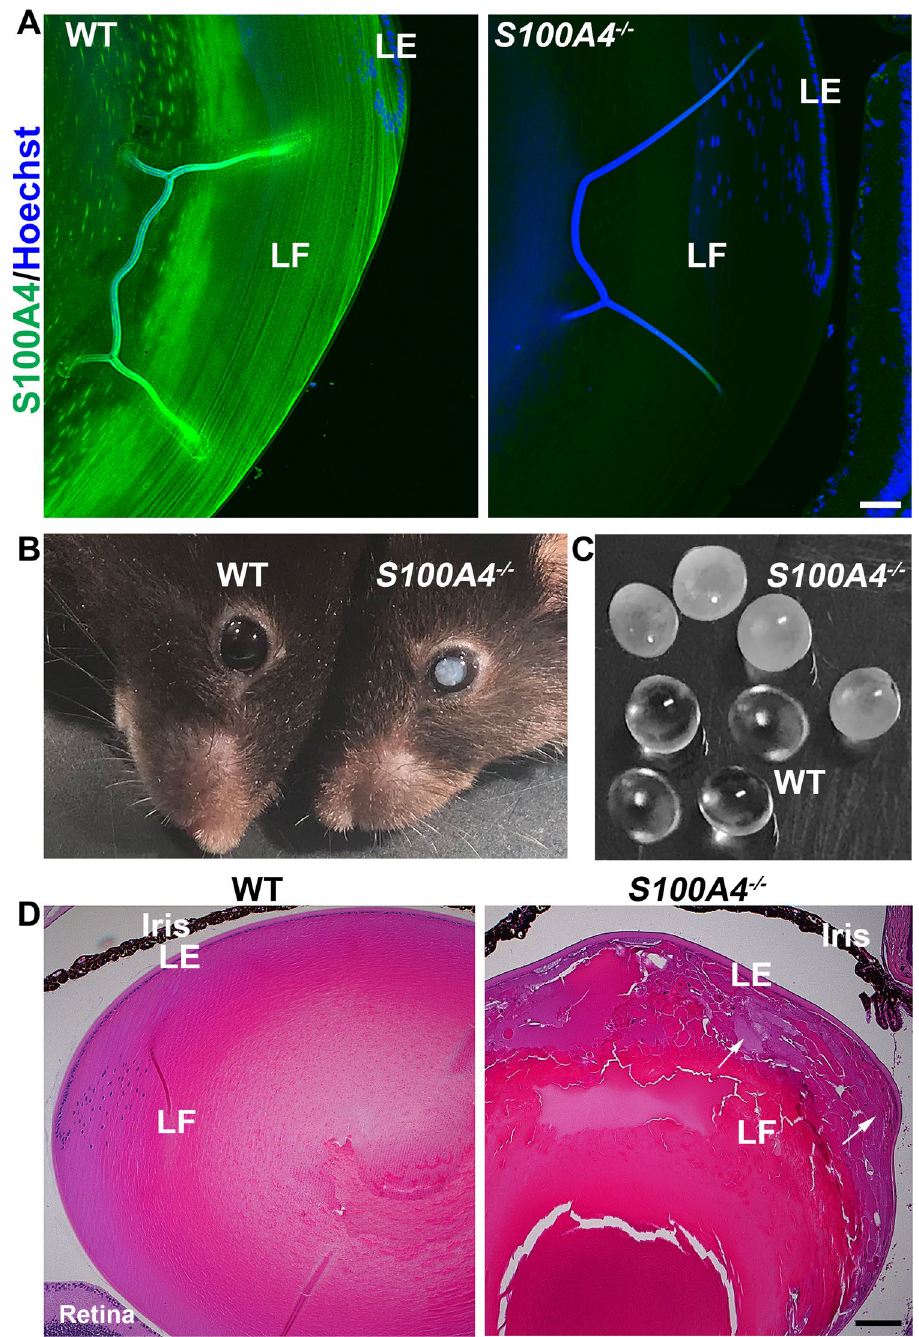
Figure 2. S100A4 deletion induces late-onset opalescent cataract in the mouse. ( A ) Confirmation of S100A4 absence in P30 S100A4 −/− mouse lens relative to WT littermate lenses based on immunofluorescence analysis. Scale bar 50 µm. ( B ) A 9-month-old S 100A4 −/− mouse exhibits an opalescent cataract phenotype compared to the clear lens in a littermate WT mouse. ( C ) Enucleated lenses from 9-month-old S100A4 −/− mice show opalescent opacity compared to clear lenses of WT mice. ( D ) Histological analysis (hematoxylin and eosin staining) of the lens from 8.5 months-old S100A4 −/− mouse reveals extensive swelling and disorganization of cortical fibers (indicated with arrows). Representative images are taken from three biological replicates. LE lens epithelium, LF lens fibers. Scale bar 100